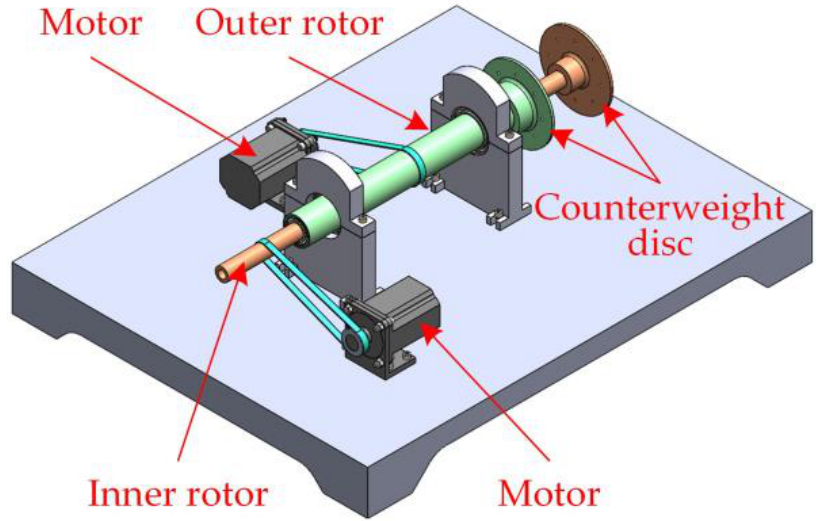
Figure 4. The cantilever dual-rotor test bench.